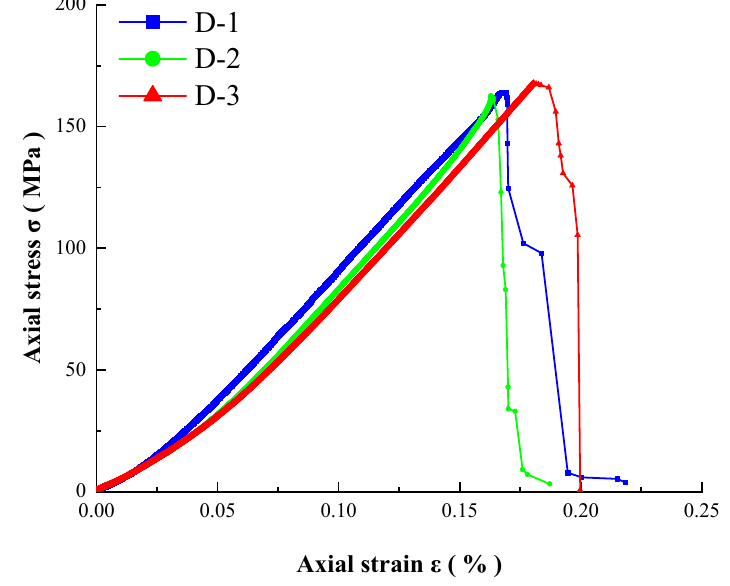
Figure 5. Stress–strain curve of intact granite.